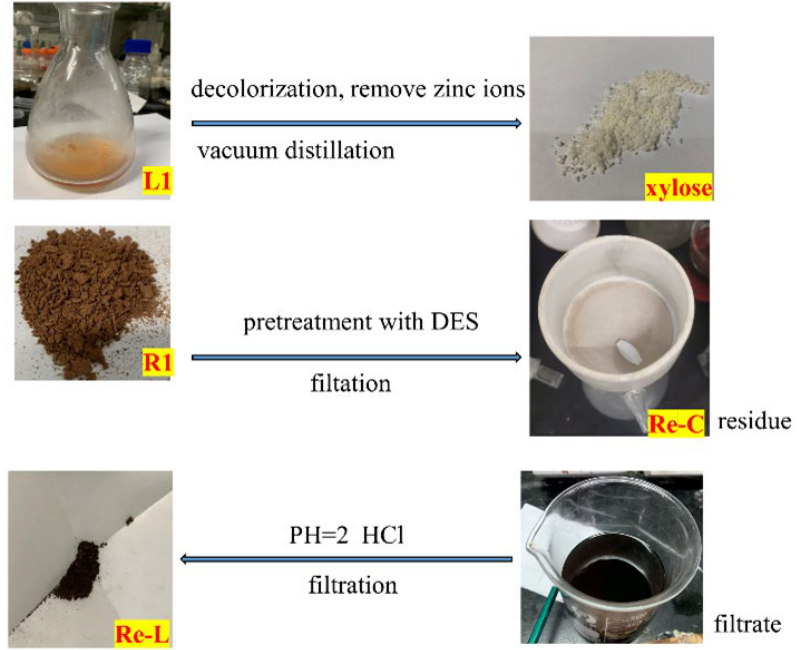
Figure 3. Fractionation of the solid residue of the first-step reaction to cellulose Re-C and lignin Re- L.